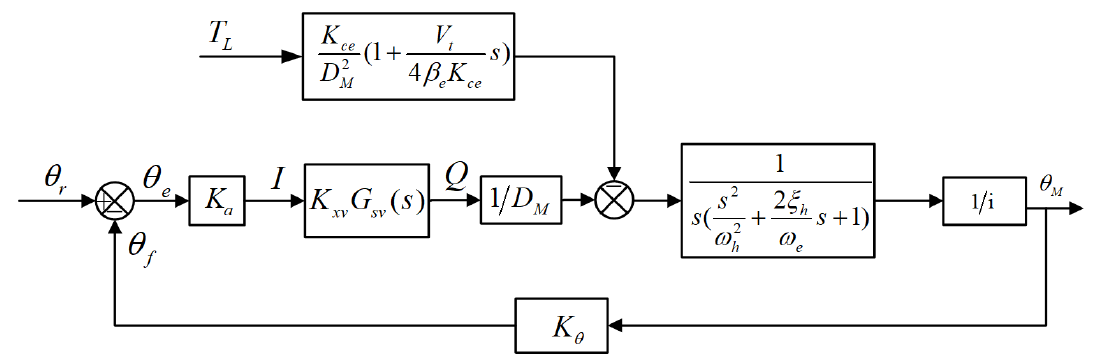
Figure 8. The angle control block diagram of the heading angle adjustment circuit.